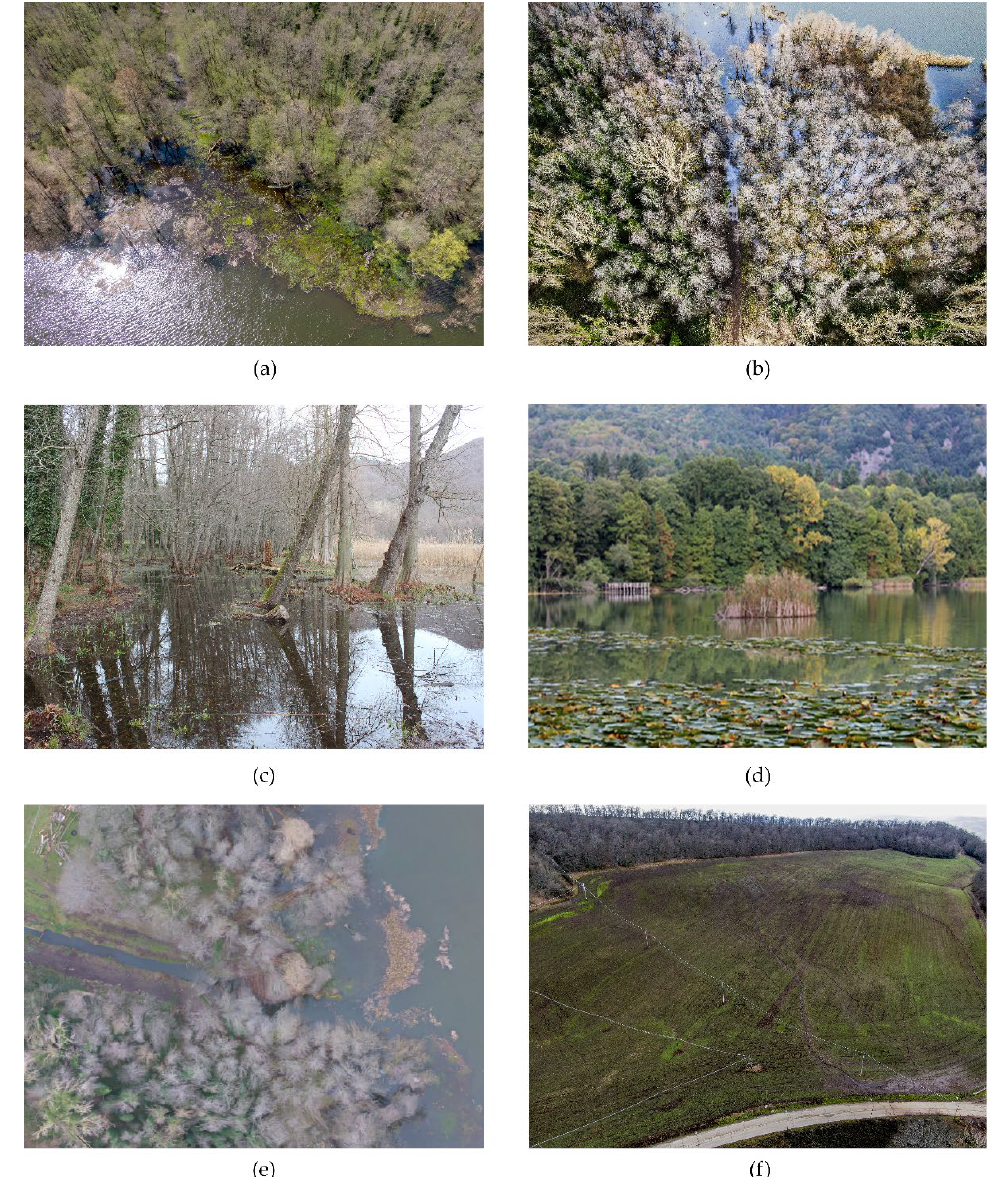
Figure 7. Flooded coastal